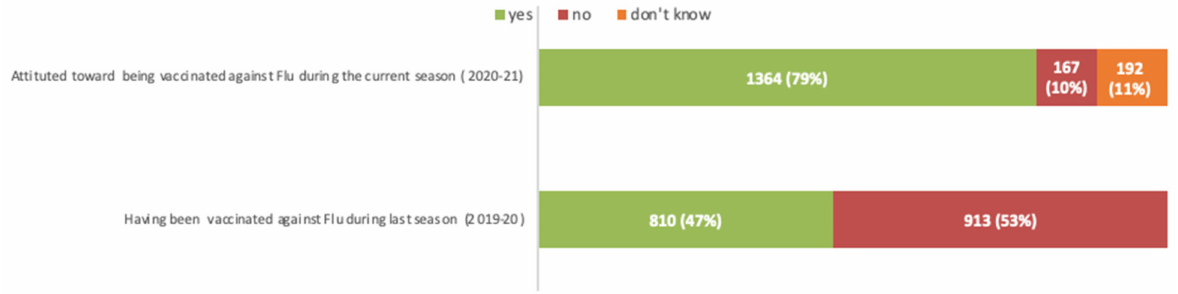
Figure 1. Attitude towards vaccination against seasonal Flu: comparison between the current (2020–2021) and the last flu season (2019–2020).